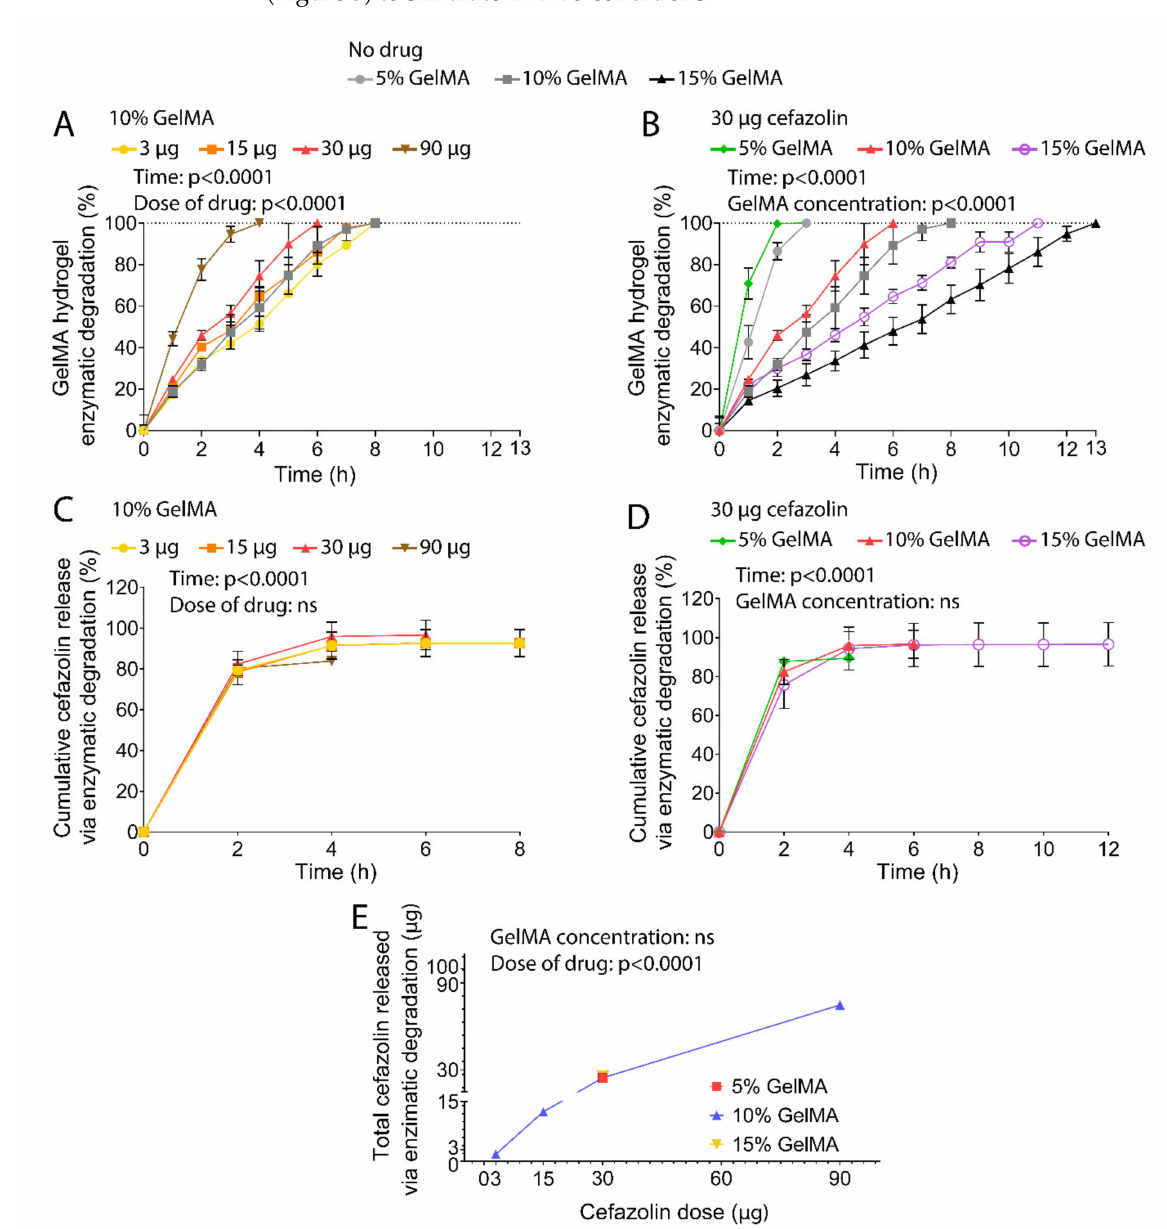
Figure 3. In vitro proteolytic release of cefazolin via collagenase II degradation of GelMA hydrogels at 28 units/mL under 300 rpm agitation at 37 ◦ C. ( A ) Hydrogel degradation defined as mass loss normalized to initial mass for 5%, 10%, and 15% GelMA and 3 µ g, 15 µ g, 30 µ g, and 90 µ g of Cefazolin in 10% GelMA. ( B ) Hydrogel degradation in mass loss normalized to initial mass for 5%, 10%, and 15% GelMA and 30 µ g of Cefazolin in 5% and 15% GelMA. Data are shown as mean ± standard deviation. The experiment was performed once with n = 4. Cumulative release as the percentage of the respective encapsulation efficiencies from GelMA hydrogels. ( C ) Cumulative release of Cefazolin 3 µ g, 15 µ g, 30 µ g, and 90 µ g from 10% GelMA. ( D ) Cumulative release of Cefazolin 30 µ g from 5%, 10%, and 15% GelMA. ( E ) Total cefazolin released via enzymatic degradation in µ g. Data are shown as mean ± standard deviation. Standard deviations that are not distinguishable are too small thus occluded by the symbols. The experiment was performed once with n =